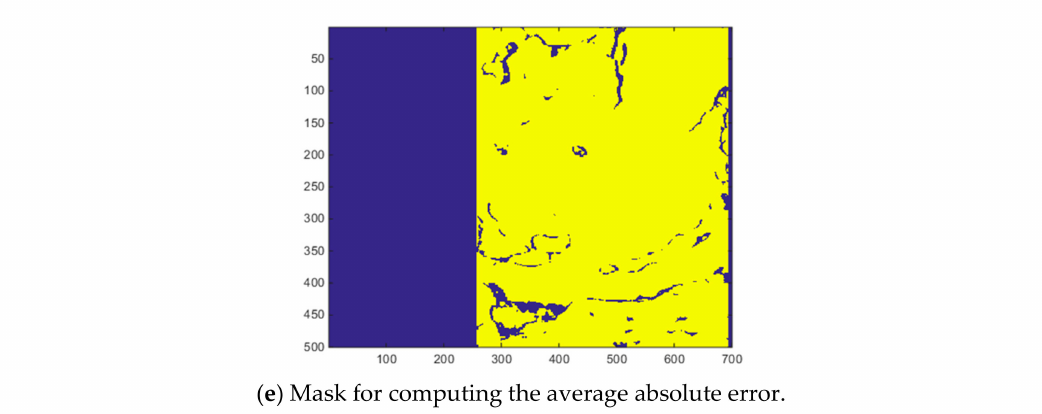
Figure 8. Disparity map estimations with the three methods and the mask for computing average absolute